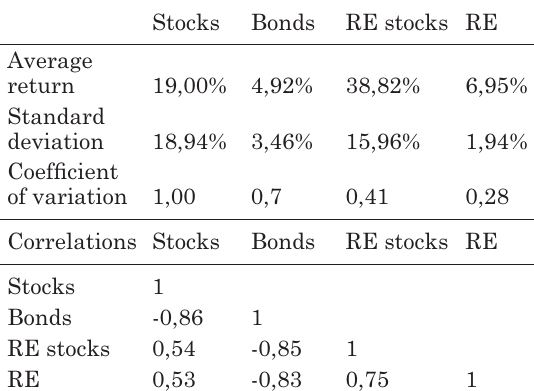
Table 1. Descriptive statistics and